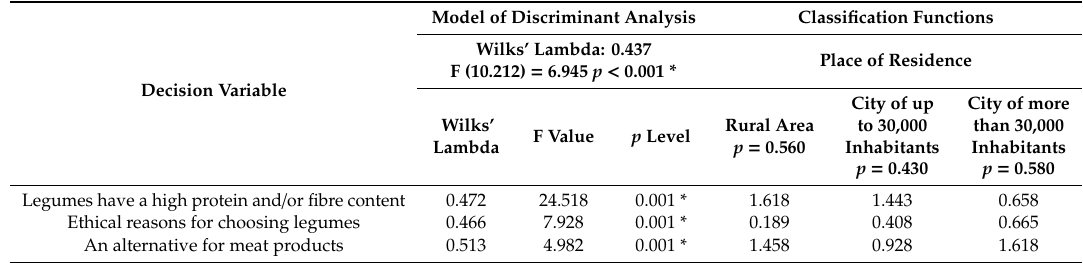
Table 3. Consumer decision-making variables taken into account when